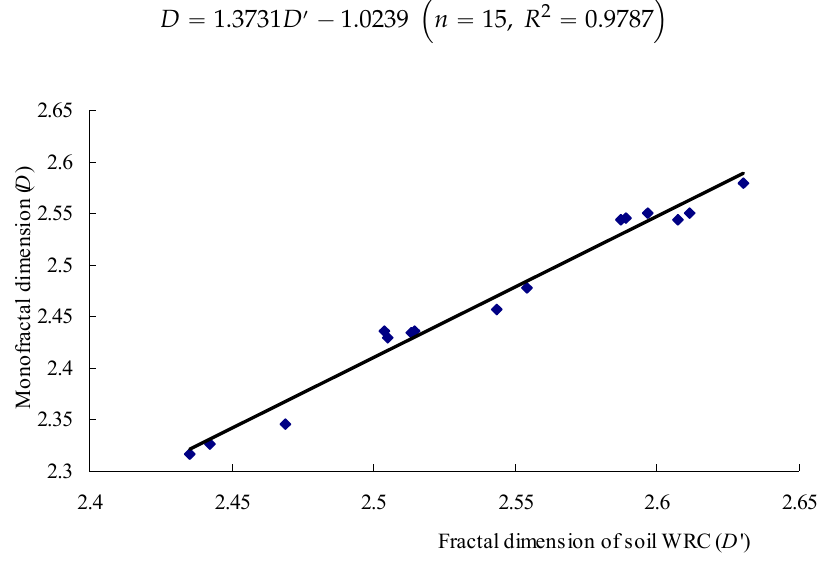
Figure 5. Correlation analysis between D ′ and D of soil PSD in the study area.